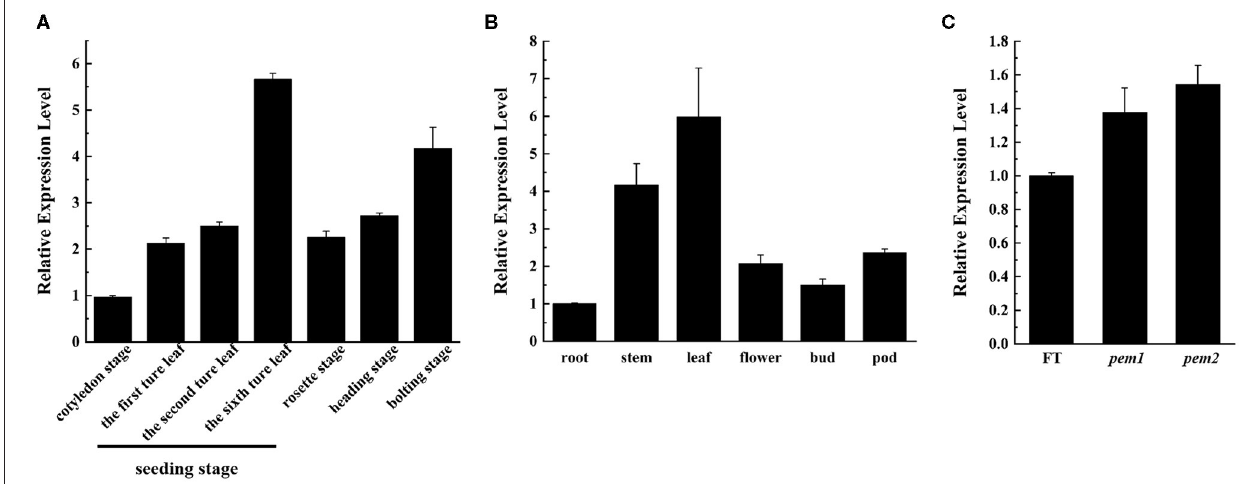
FIGURE 7 | The expression level of BrDVR. (A) Expression of BrDVR in various organs of “FT”: root, stem, leaf, flower, bud, and pods. (B) Expression of BrDVR at different stage in “FT” leaves: cotyledon, seedling: the first, third, and sixth true leaves, rosette, heading, and bolting stages. (C) Expression of BrDVR in leaves among wild-type “FT,” pem1 and pem2 .